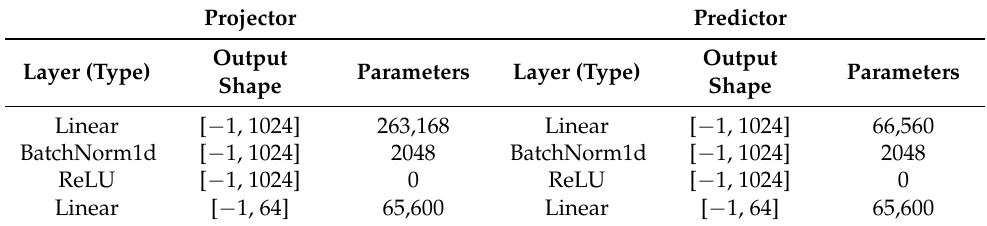
Table 2. The structures of our projector and predictor.